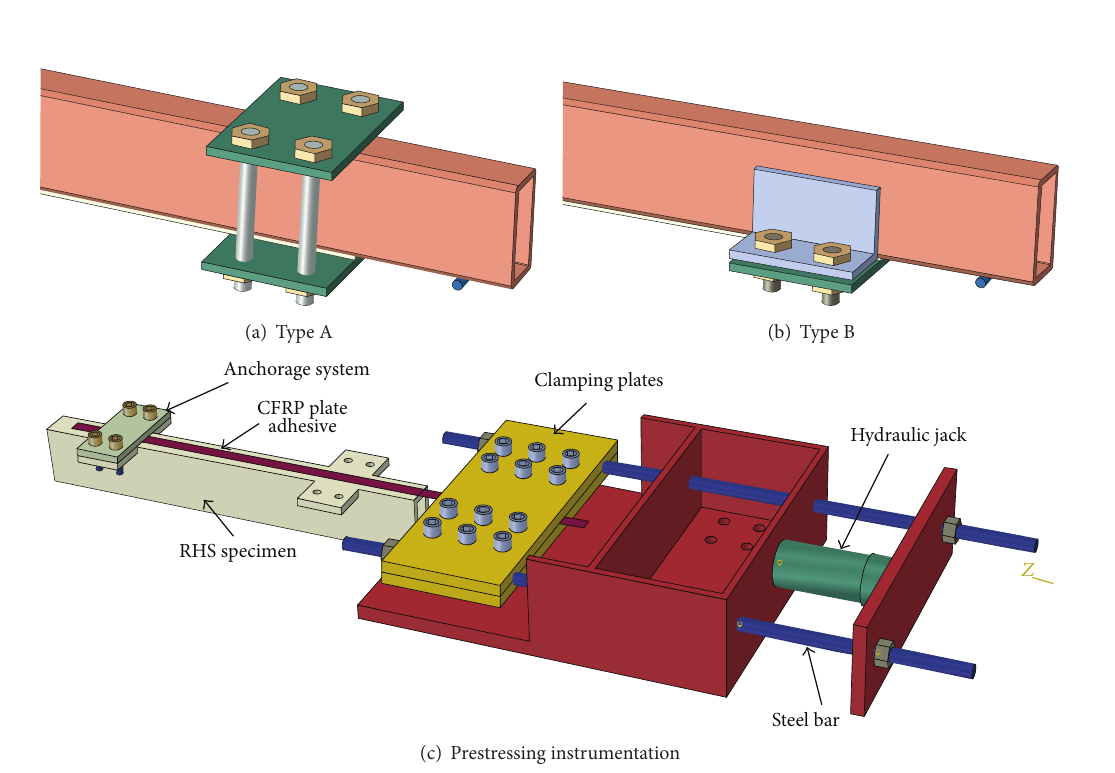
Figure 2: Anchorage systems and prestressing